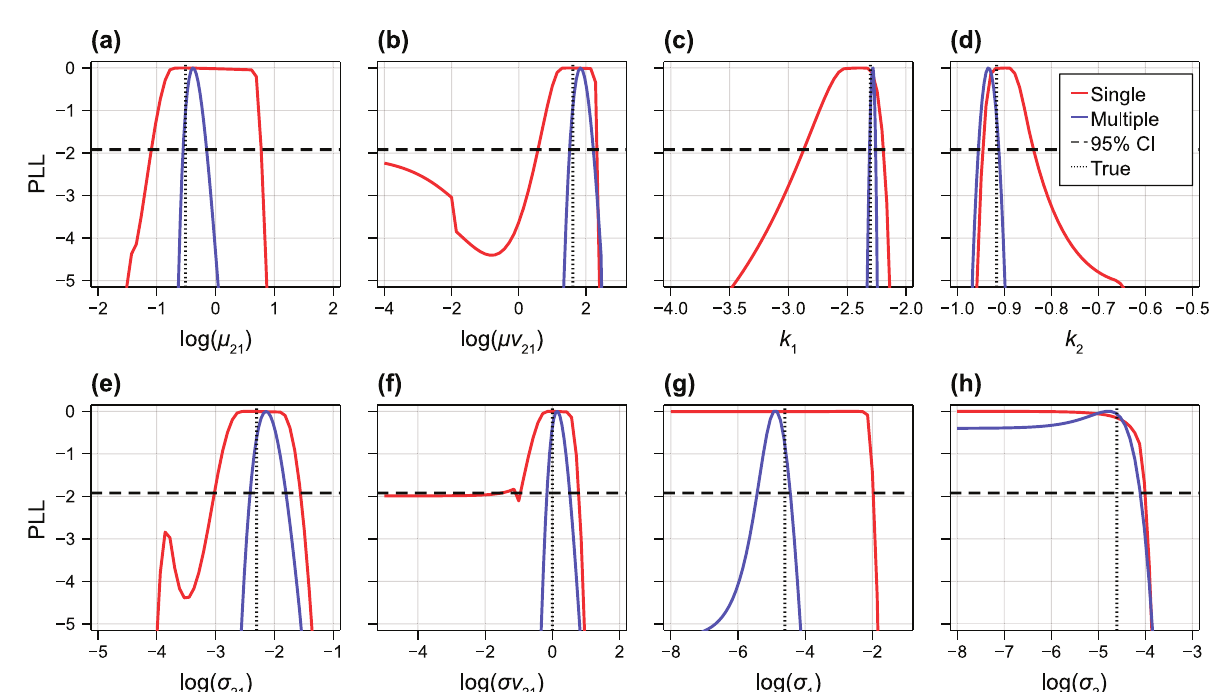
Fig 8. Identifiability analysis for the non-linear two-pool model. Profile likelihoods for each parameter where the data comprise N = 20 observations each from five observation times (blue) and N = 100 observations at a single observation time.